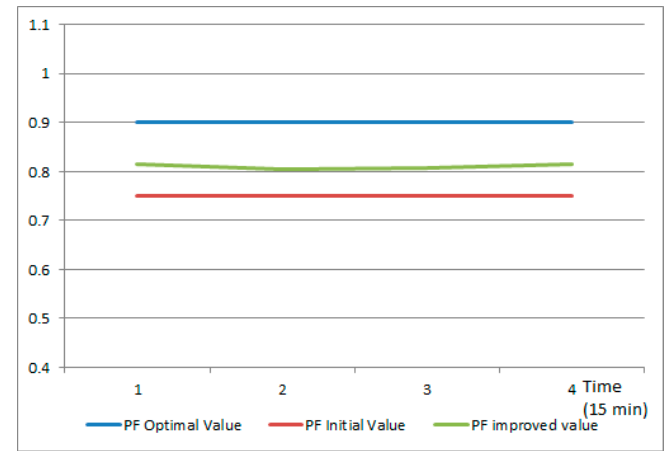
Figure 10. Power factor improvement as result of VPP construction and service delivery.